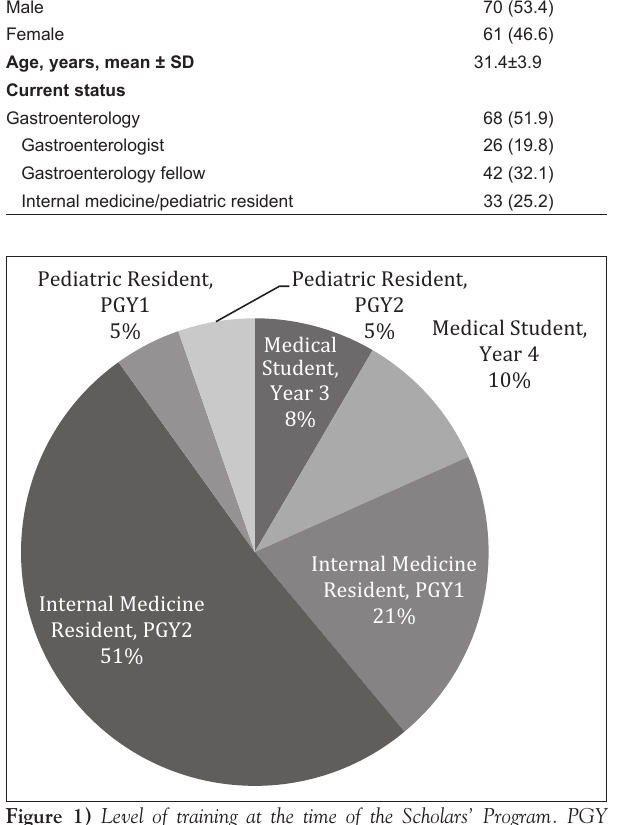
Figure 1) Level of training at the time of the Scholars’ Program. PGY